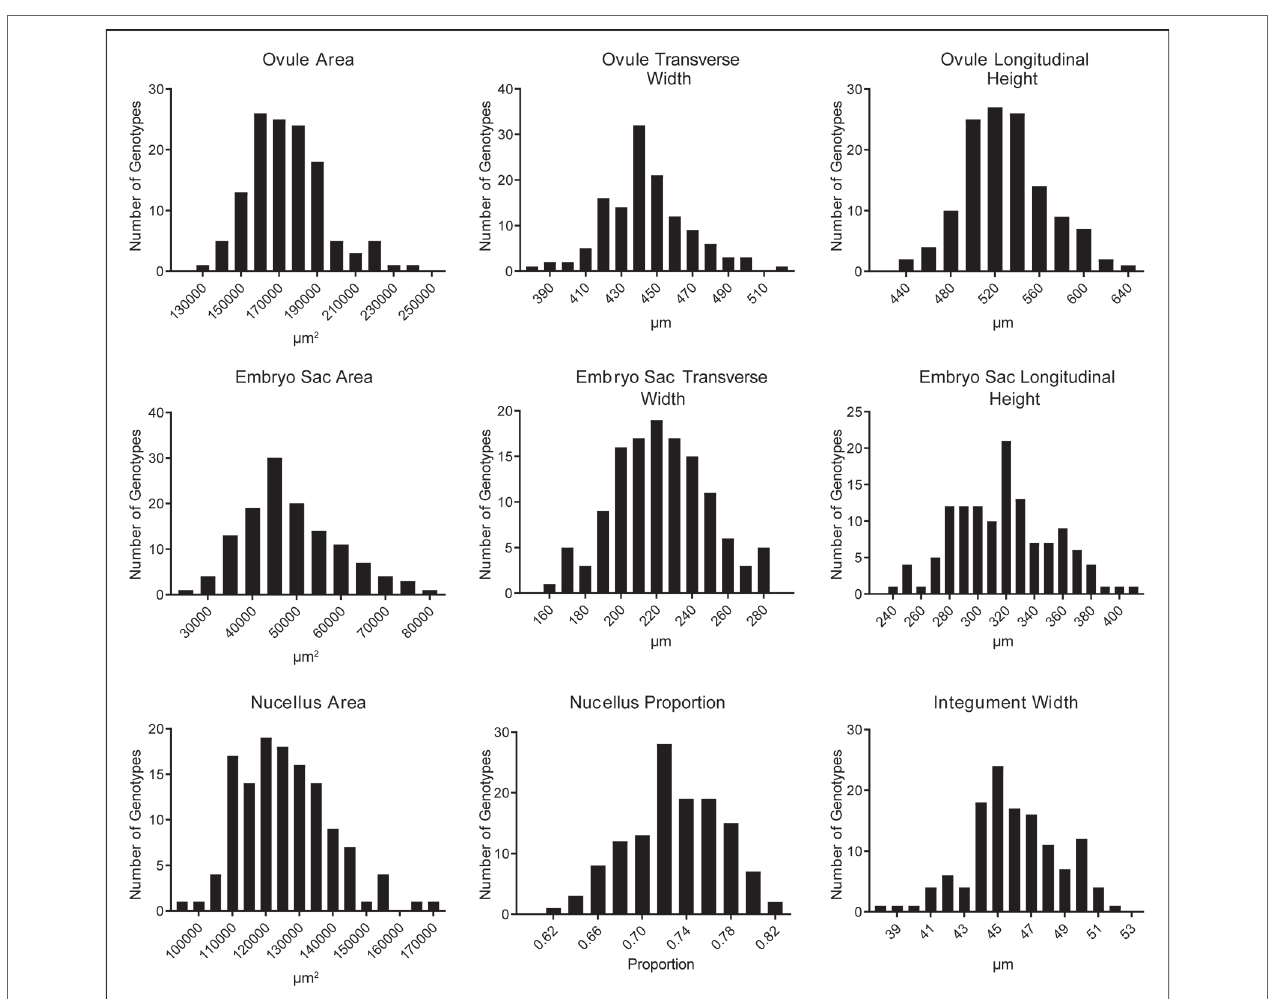
FIGURe 2 | Natural variation in nine mature ovule traits observed in 127 genotypes of European two-row spring barley, represented as frequency distribution plots.